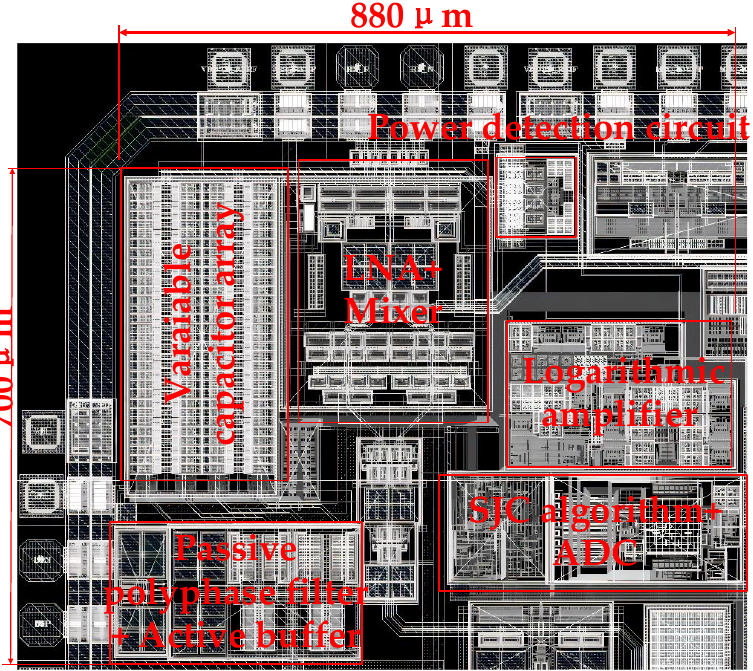
Figure 15. Layout photograph of the SJC circuit.